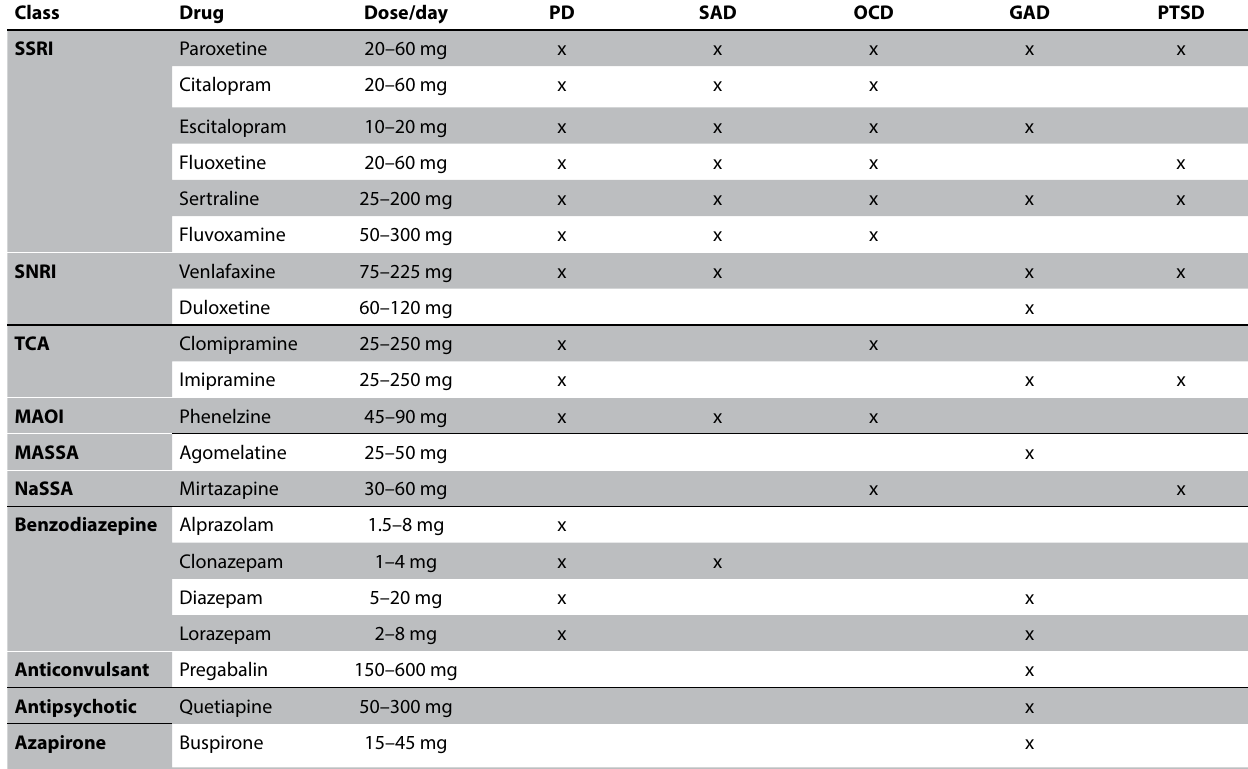
Table Il: Drug treatment options for the anxiety disorders, OCD and PTSD (Adapted from World Federation of Societies of Biological Psychiatry Guidelines 14 )